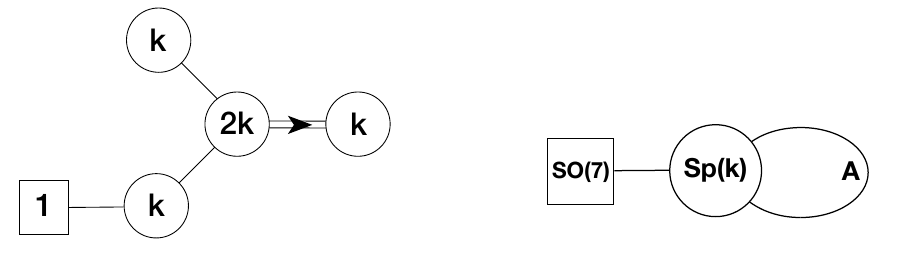
Figure 2 . ADHM quiver for k SO(7) instantons (right) and its dual quiver with b B 3 symmetry (left).